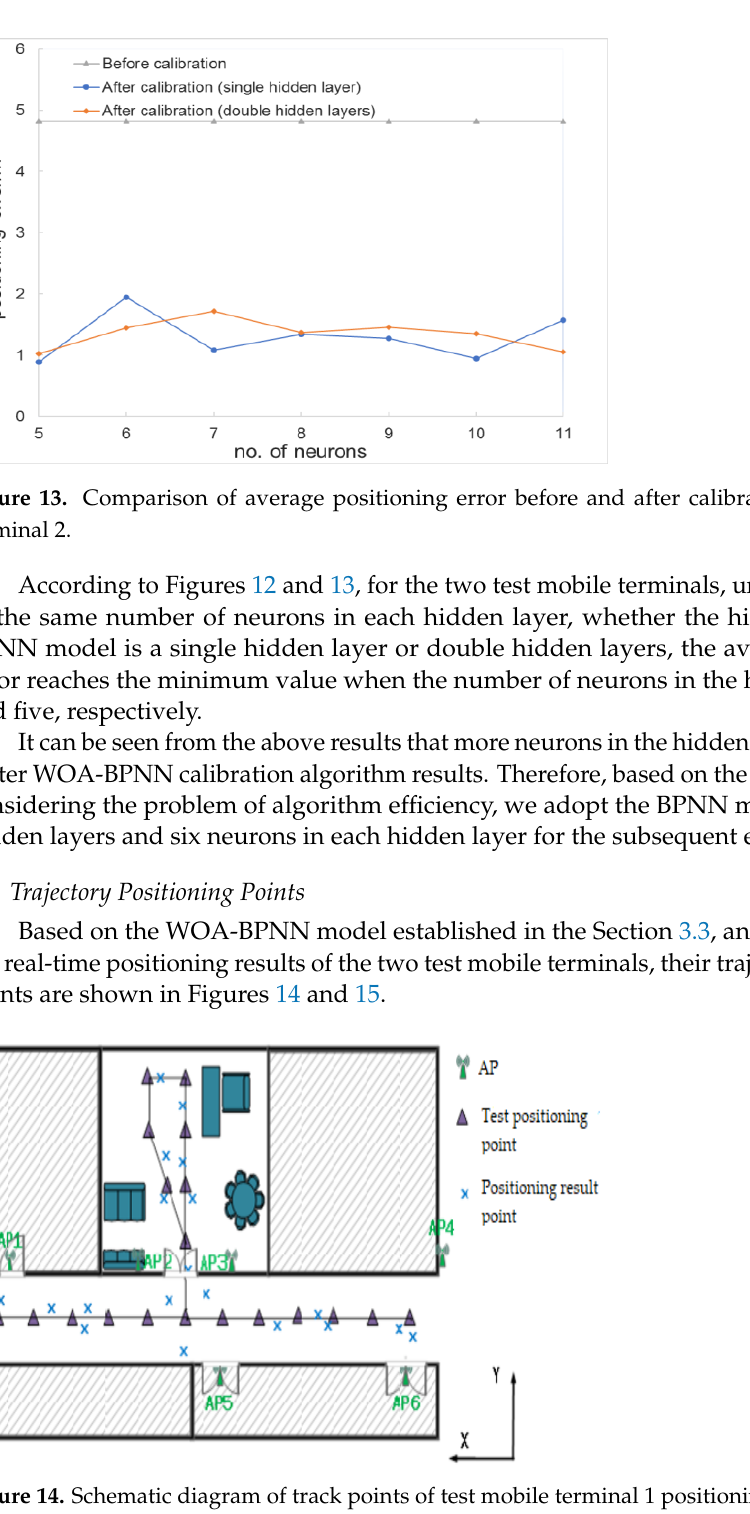
Figure 12. Comparison of average positioning error before and after calibration of test mobile ter- minal 1.